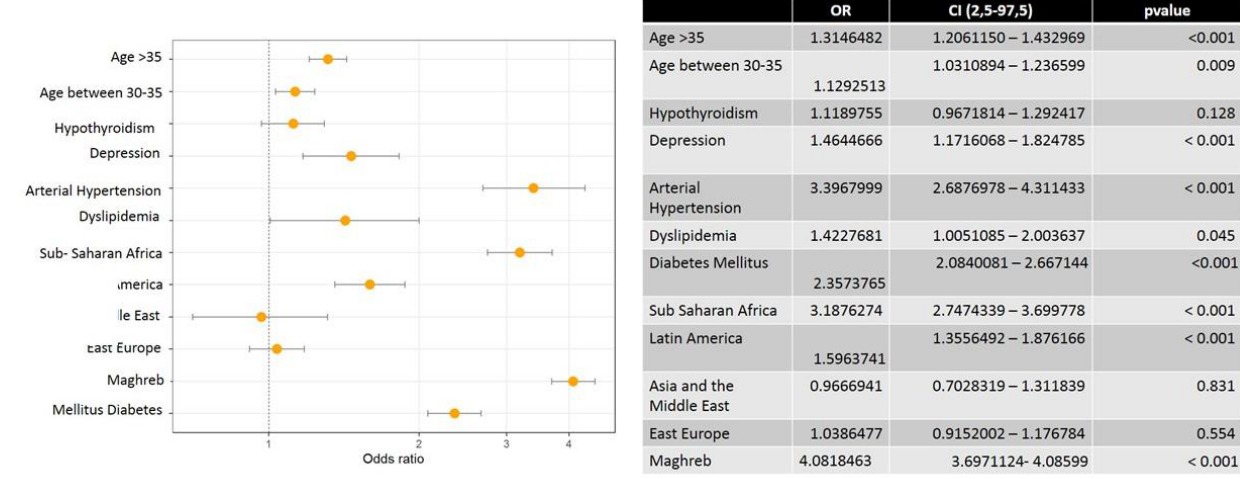
Figure 1. Multivariate analysis of the association of maternal risk factors in women with body mass index (BMI) > 25.